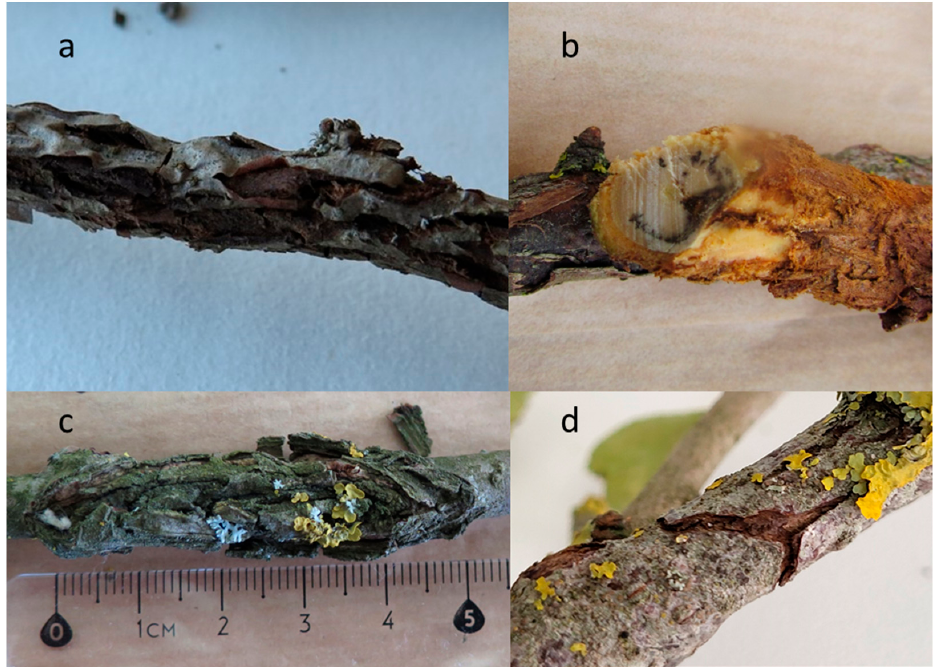
Figure 3. Damage to Japanese quince shoots: ( a ) the bark peeled off from the damaged area; ( b ) damaged shoot in cross section; ( c ) oval wound with dead bark; ( d ) cracked bark. During our studies, a total of 538 fungal isolates were obtained from Chaenomeles japonica and identified at the genus level. These obtained isolates correspond to 36 genera of fungi. The relative density exceeded 2% for only 10 genera, with the majority rarely found based on incidence (Figure 4).